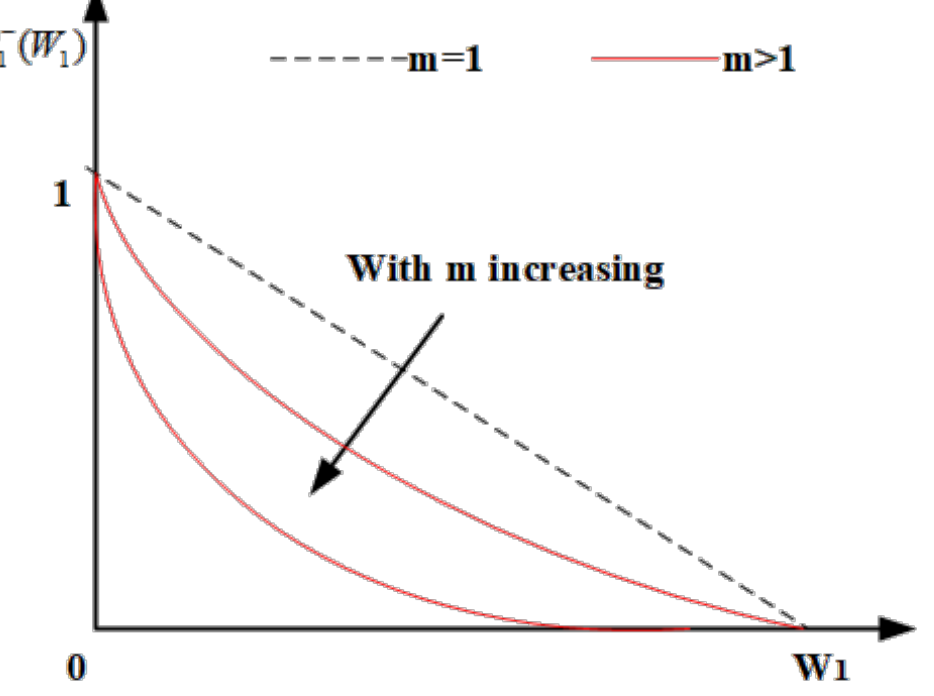
Figure 5. Diagram of the relationship between water volume storage in advance and added value of benefit in stage 1.